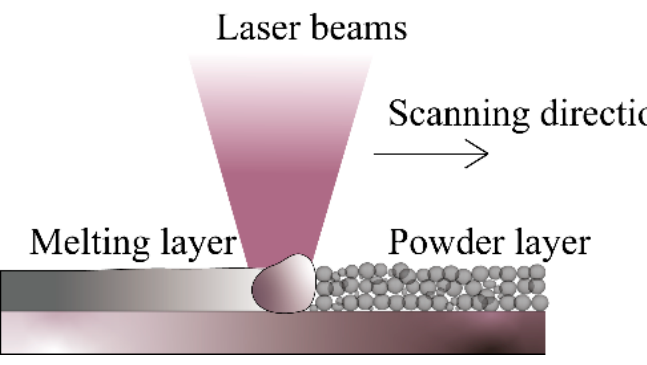
Figure 10. Schematic diagram of laser melting. SLM is a technology that has been commonly used to manufacture metal mirrors in recent years, as shown in Table 3. In theory, forming parts via SLM have higher density and mechanical properties than via laser sintering. SLM’s products have high dimensional accuracy, a smooth surface, and high density [42]. The laser power of SLM solutions’ 3D printer can reach 700 W easily, which is high enough to pre-print mirror blanks. SLMed parts’ density is up to 99.0% and above. The above technical advantages have gradually promoted SLM to the mainstream technology for fabricating AM metal